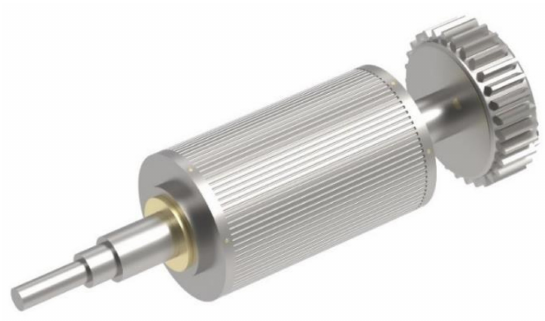
Figure 18. Upper cylinder subassembly.